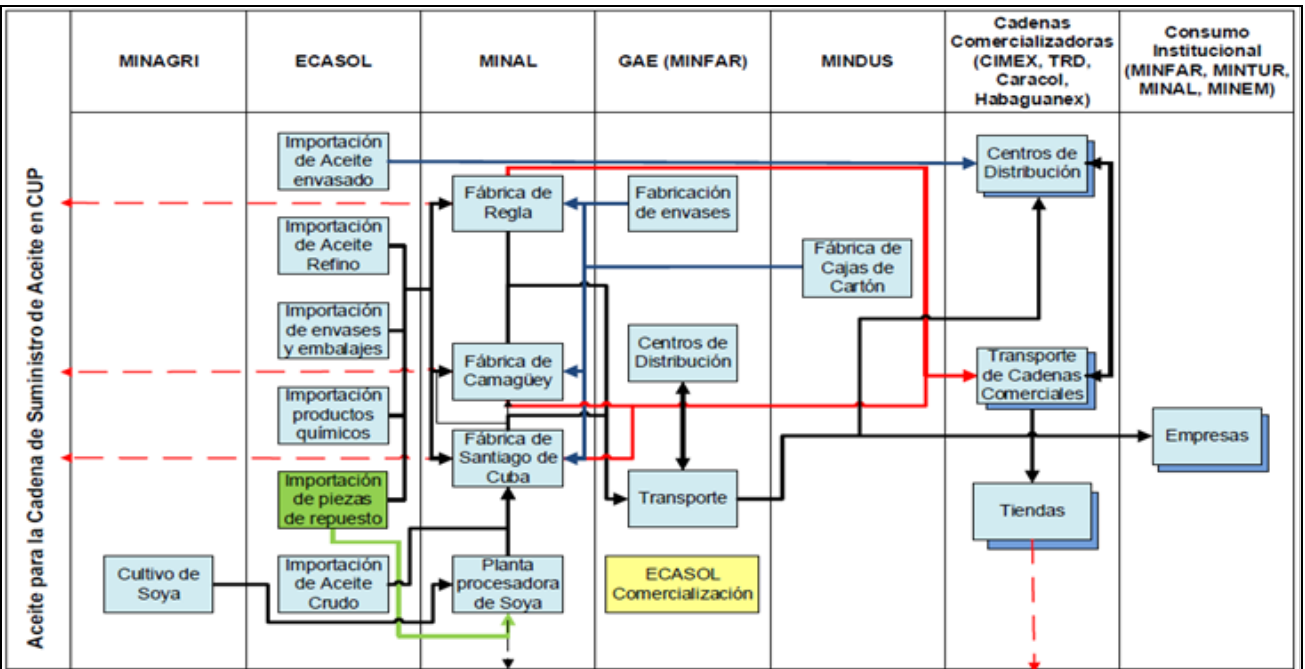
Figura1: Cadena de Suministro de Aceite Comestible Comercializado en CUC . Fuente: Los autores,